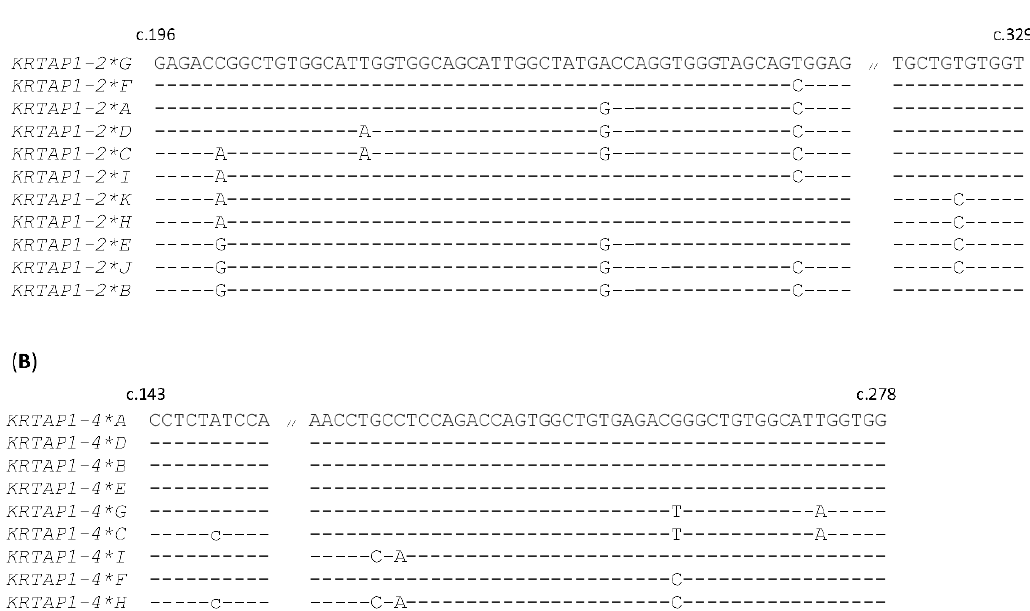
Figure 5. Sequence comparisons revealing potential DNA exchanges between variants of ovine KRTAP1-2 ( A ) and KRTAP1-4 ( B ). Nucleotides identical to the top sequences are presented as dashes, and the numbering of the nucleotide positions follows the Human Genome Variation Society (HGVS) nomenclature (http://varnomen.hgvs.org/).